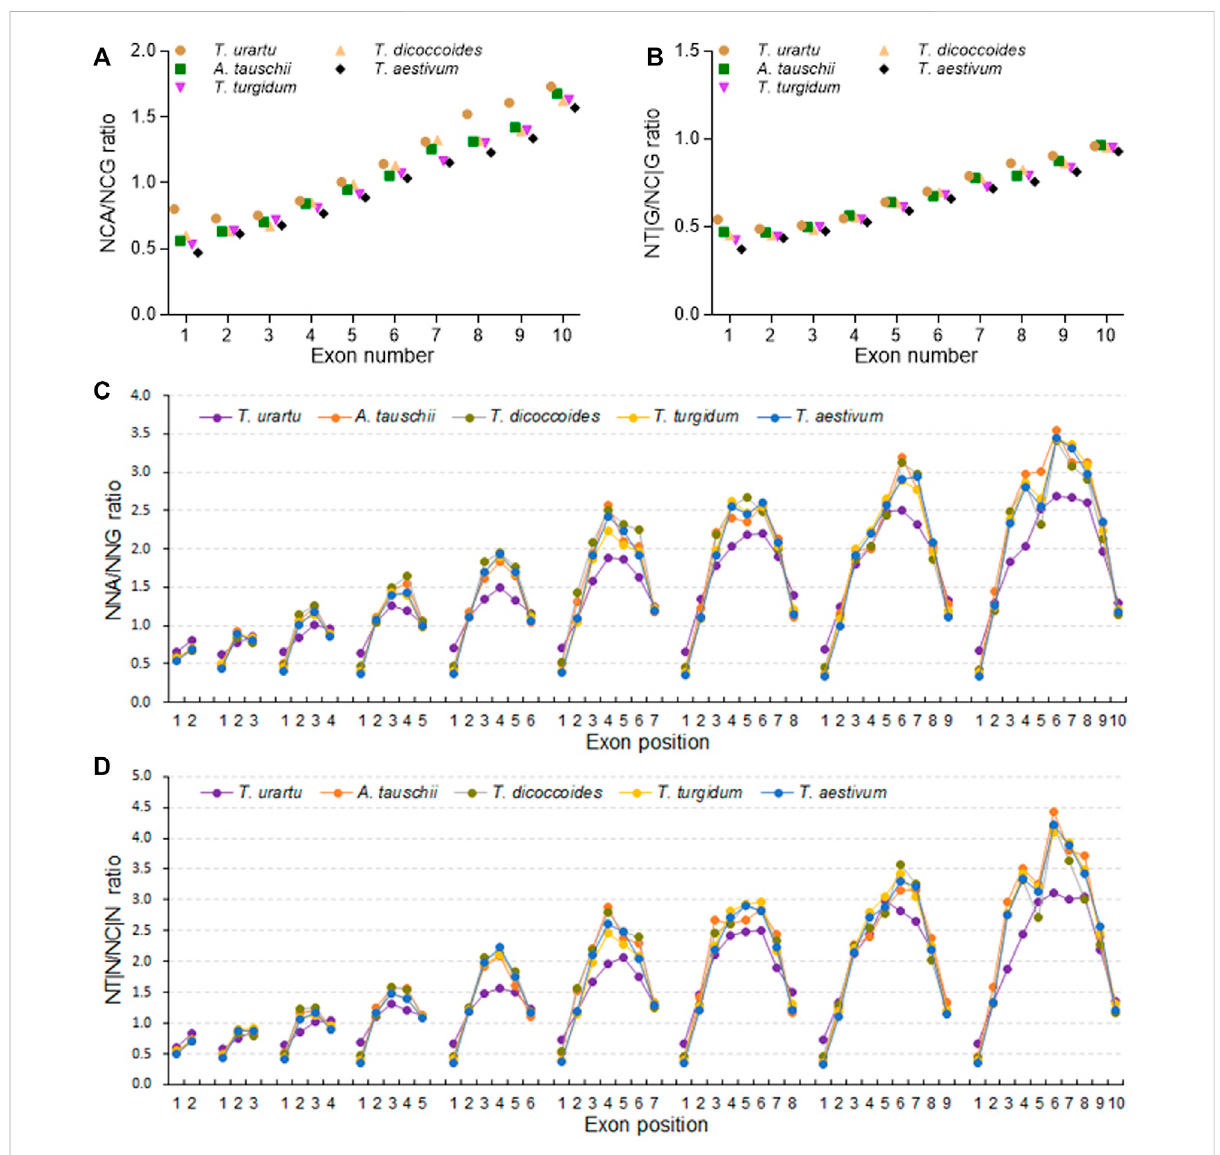
FIGURE 6 Association between DNA methylation and SCUB heterogeneity as a function of exon number and position. (A) Ratios between NCA and NCG codons in genes with up to nine introns. (B) Ratios between NT|G and NC|G triplets in genes with up to nine introns. (C) Ratios between NCA